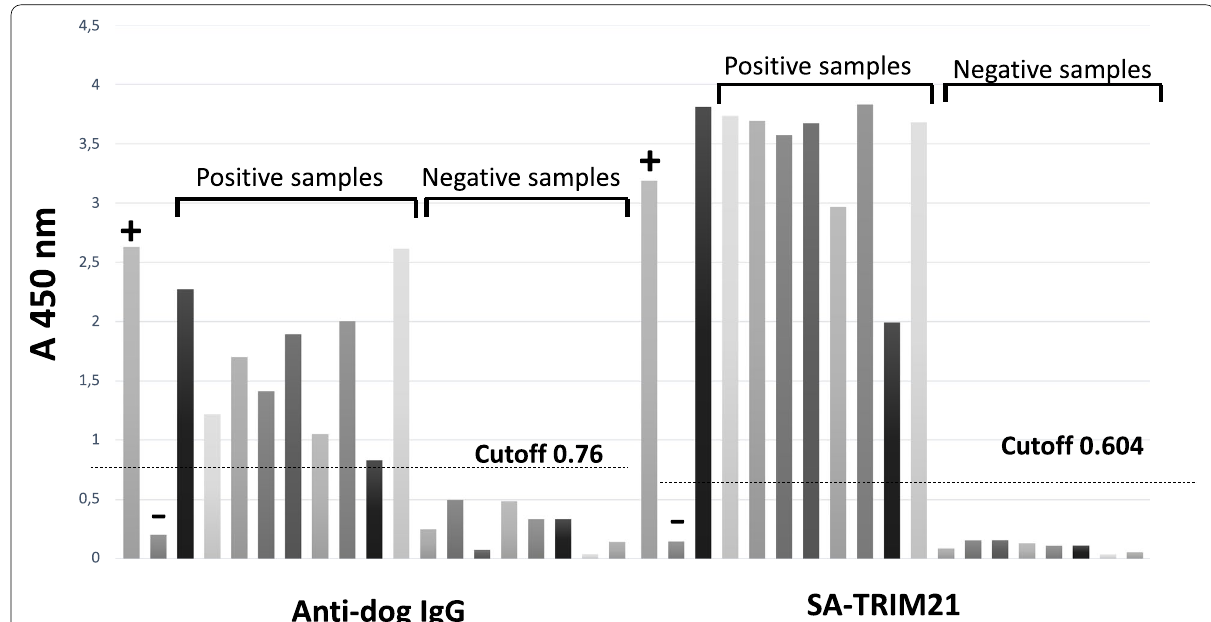
Fig. 5 Performance of SA-TRIM21 for IgG detection on veterinary ELISA kits: Anti-Leishmania IgG detection in dog serum. Wells were coated with specific L. infantum antigens, followed by incubation with dog serum samples. Wells were washed followed by incubation with HRP coupled anti-IgG or SA-TRIM21. After washing, the chromogen TMB was added to the wells followed by incubation during 10 min. Reactions were quenched using Stop solution and absorbance was read at 450